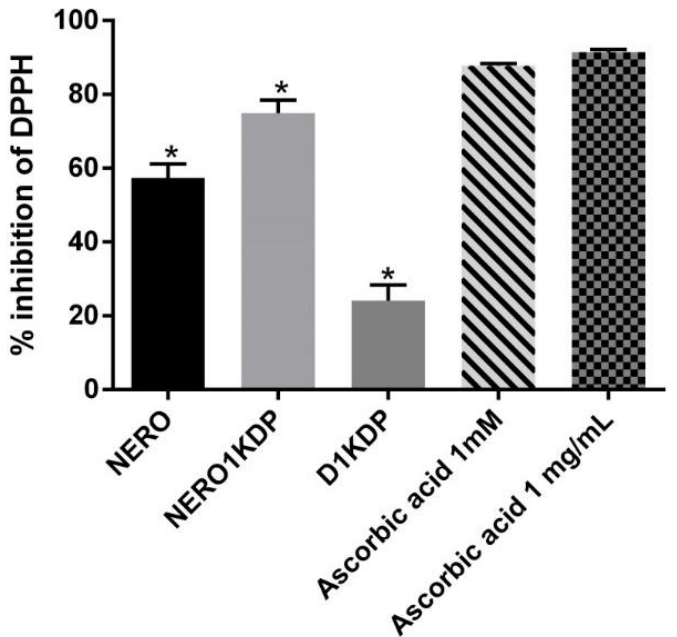
Figure 6. DPPH inhibition percentage of unloaded nanoemulsion (NERO), 1 mg/mL kojic dipalmi- tate (KDP)-loaded nanoemulsion (NERO1KDP), 1 mg/mL KDP dispersion (D1KDP), and positive controls (1 and 0.17 mg/mL ascorbic acid). One asterisk represents a significant difference from all the other samples ( p ≤